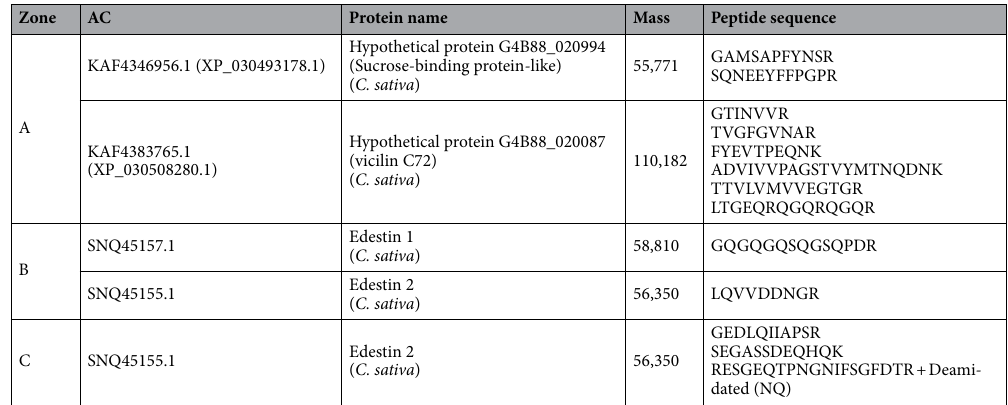
Table 5. MS/MS identifications from total protein extracts after 2D-PAGE analysis. Different gel areas, database accession code (AC), protein name and organism, theoretical molecular mass and peptide sequences are